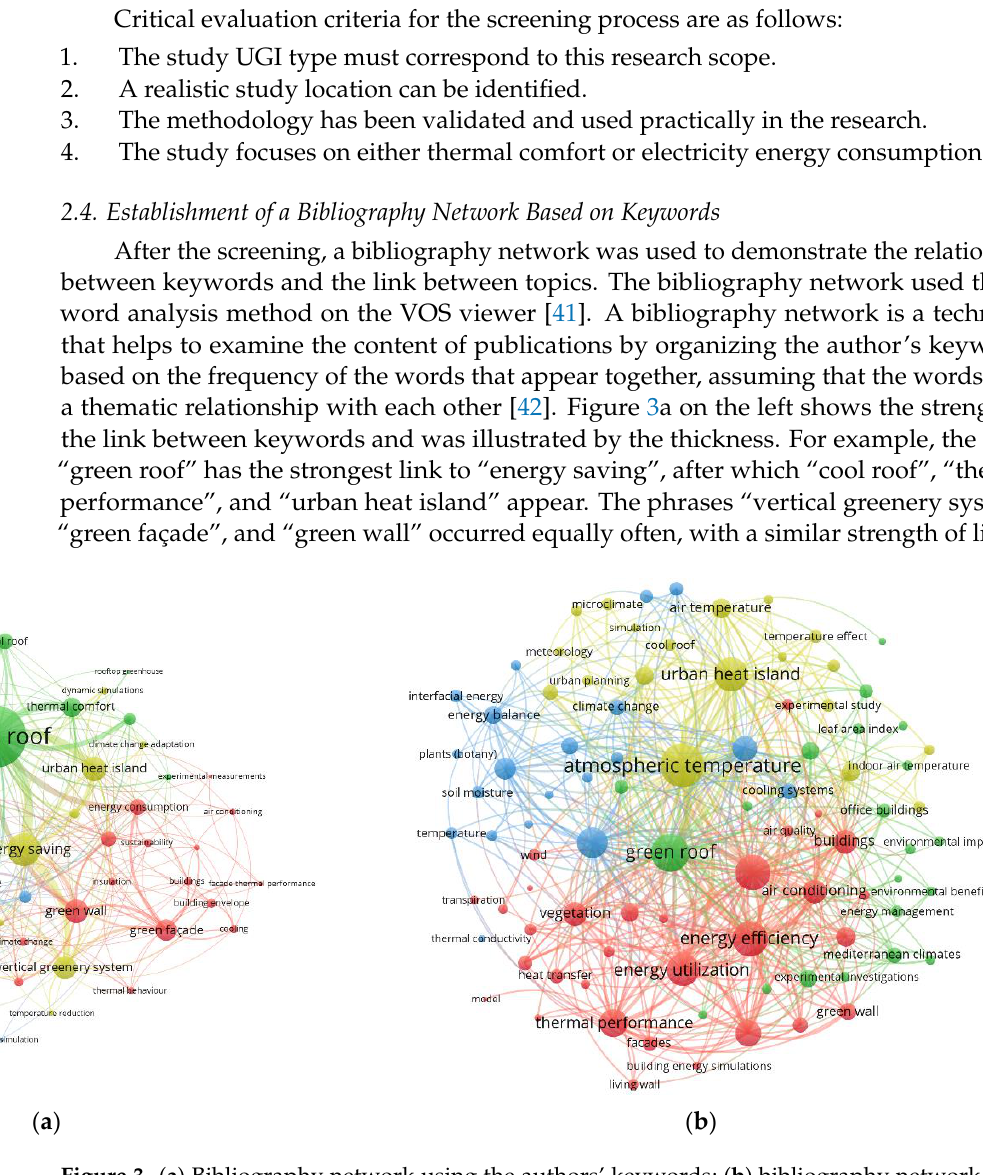
Figure 3. ( a ) Bibliography network using the authors ’ keywords; ( b ) bibliography network using index keywords.